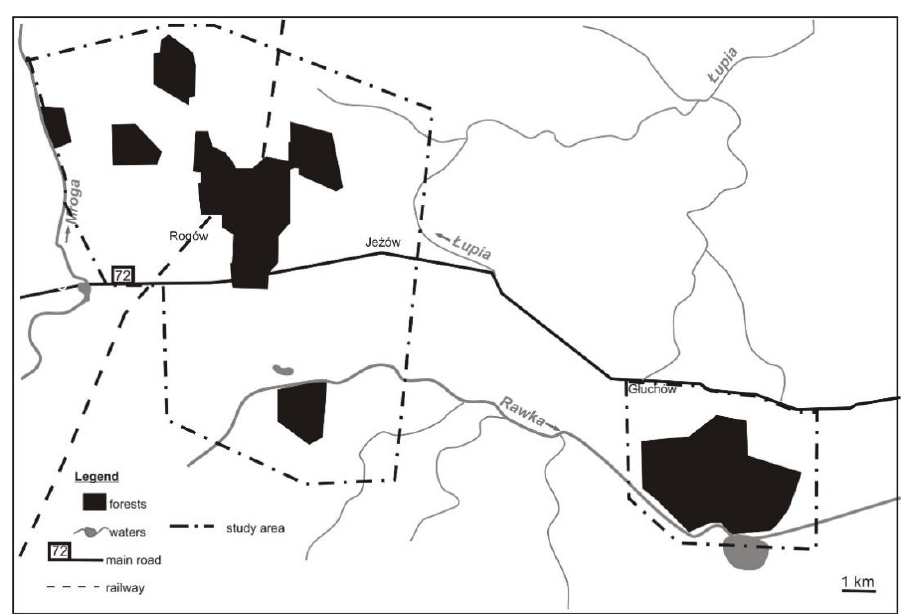
Figure 1. The distribution of forest complexes in the study area (central Poland, vicinity of Rogów village, Experimental Forest Station of Warsaw University of Life Sciences).